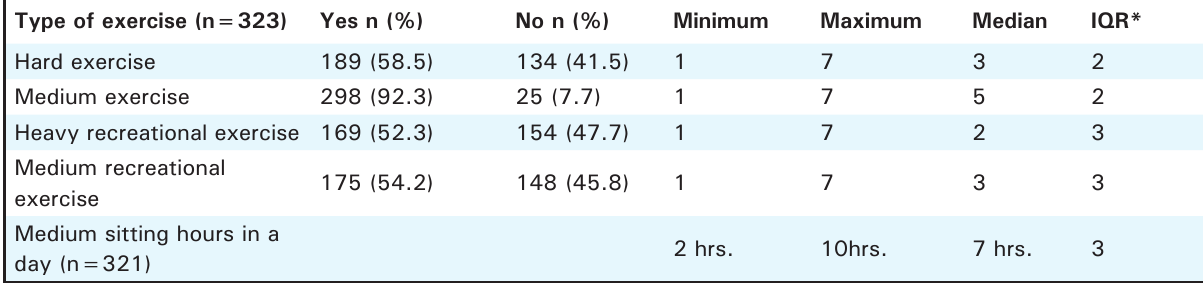
Table 6. Physical activities of the government employees.